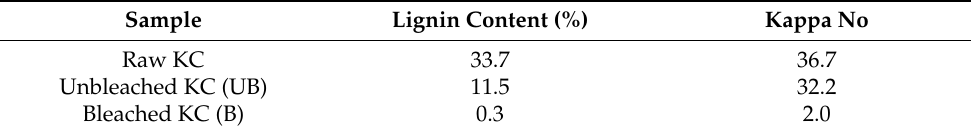
Table 4. The lignin composition and the particle size of unbleached and bleached NCC.